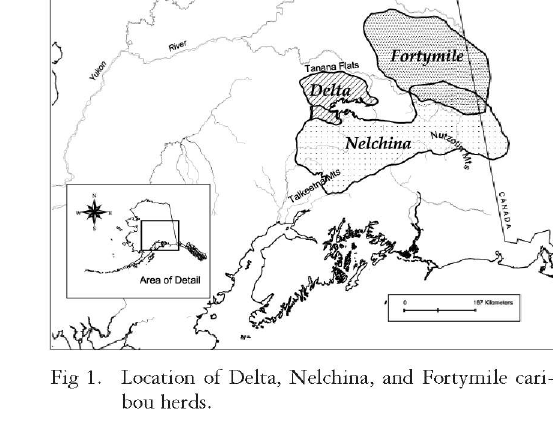
Fig 1. Location of Delta, Nelchina, and Fortymile cari bou